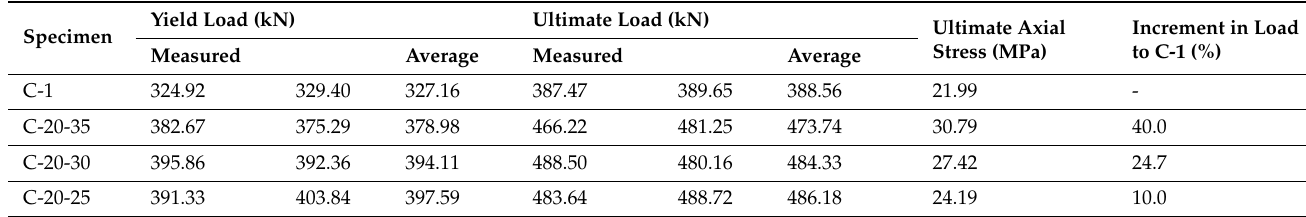
Table 2. Tested specimens’ load carrying capacity.